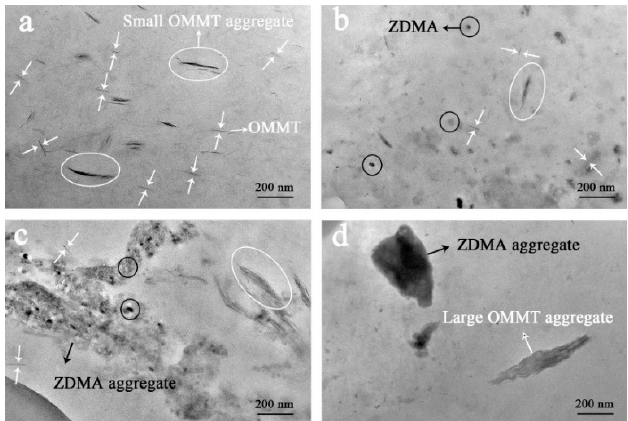
Figure 7. SEM images of ( a , b ) in-situ-NC, ( c , d ) in-situ-NC/ZDMA25, ( e , f ) in-situ-NC/ZDMA40, and ( g , h ) ph-NC/ZDMA40.